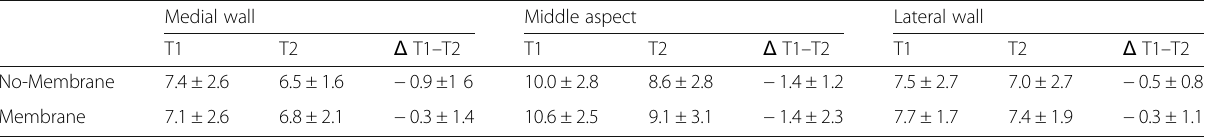
Table 4 Floor augmentation heights in the coronal view evaluated at the medial, middle, and lateral aspects of the sinus at the various periods of observation